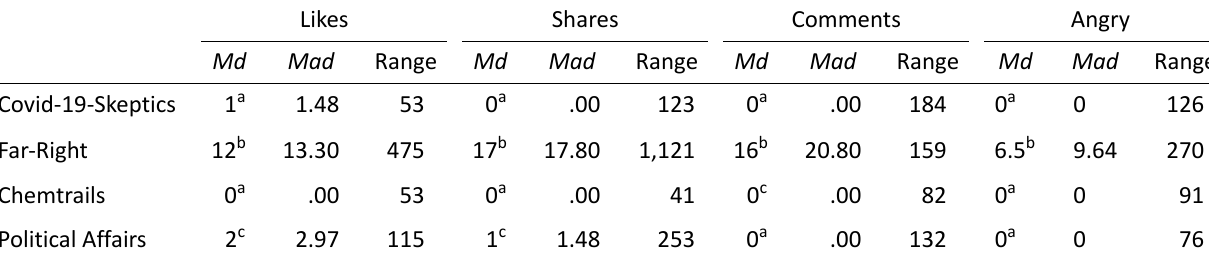
Table 7. Engagement per